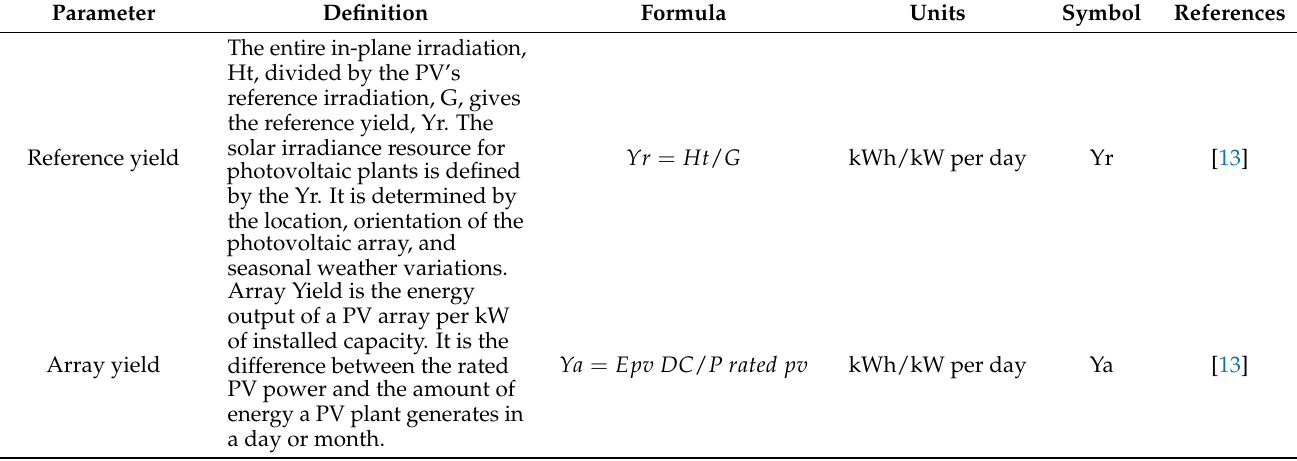
Table 1. PV power performance parameters.